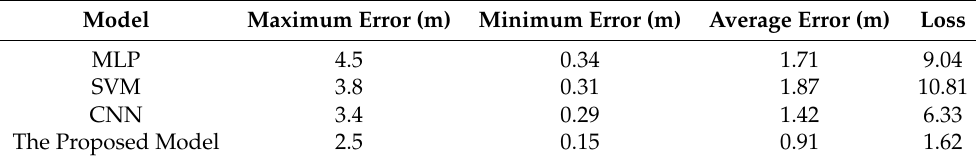
Table 2. The performance of different models on the test set.